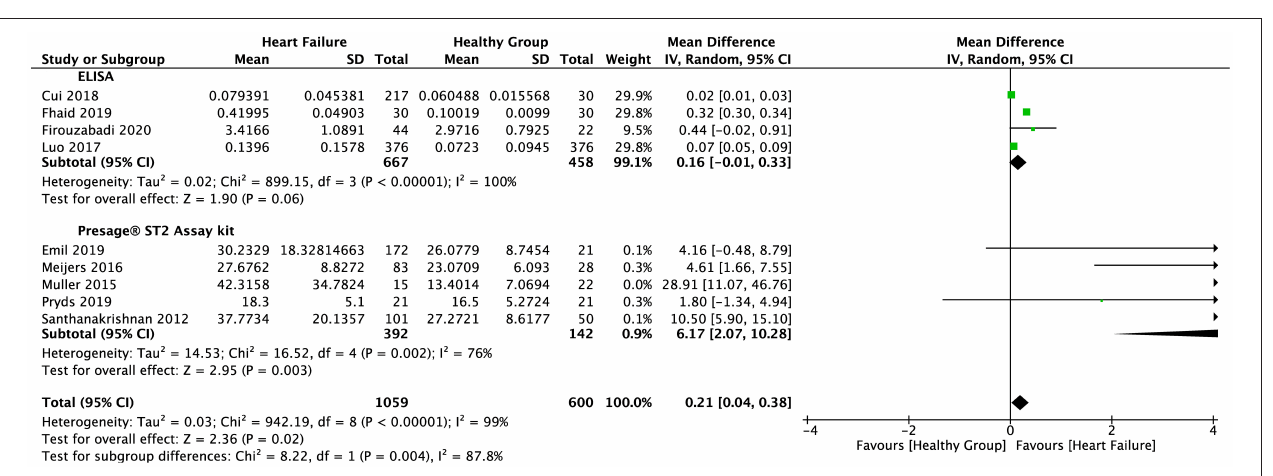
FIGURE 6 | Forest plot of sST2 levels between HF and healthy subgroups with different assay methods (ELISA and Presage® ST2 assay